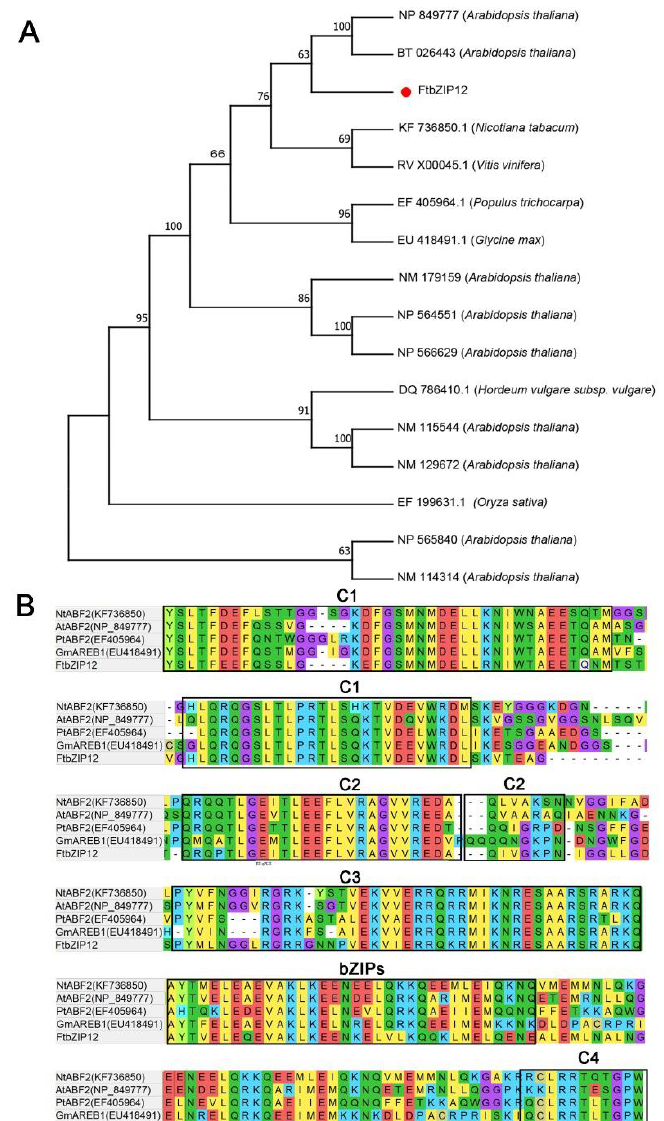
Figure 1. Multiple sequence analysis and phylogenetic tree analysis of FtbZIP12 . ( A ) Phylogenetic tree analysis of ABF subfamily in different species. ( B ) Sequence alignment of FtbZIP12 protein showing the bZIP conserved domain and the four phosphorylation groups C1–C4 represented by boxes. Among them, the tree-building sequence is cited [25,26].